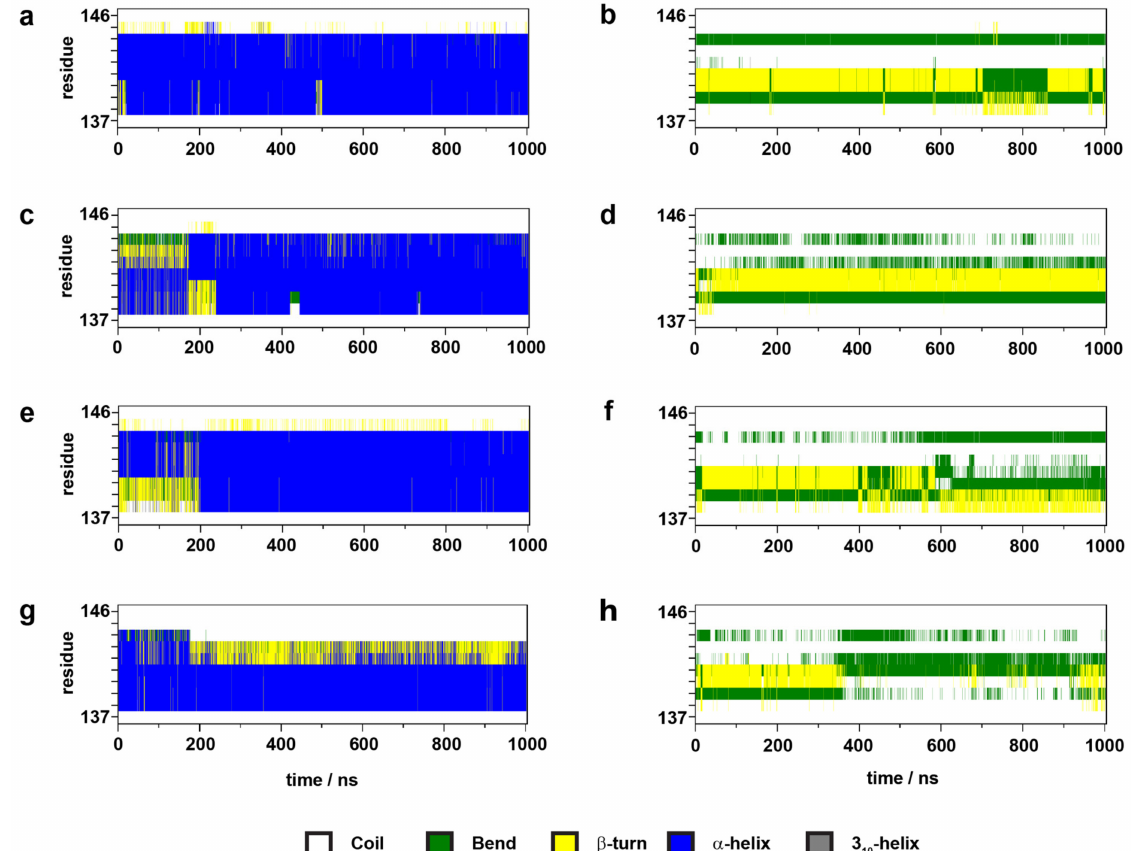
Figure 4. Evolution of the secondary structure of ICL2 during simulations. ( a ) active β 2 AR–G s protein–epinephrine complex, 1st replica; ( b ) inactive β 2 AR–G s protein – epinephrine complex; ( c ) active β 2 AR– β -arrestin-2–epinephrine complex; ( d ) inactive β 2 AR– β -arrestin-2–epinephrine complex. ( e ) active, ligand-free β 2 AR–G s protein complex; ( f ) inactive, ligand- free β 2 AR–G s protein complex; ( g ) active, ligand-free β 2 AR– β -arrestin-2 complex; ( h ) inactive, ligand-free β 2 AR– β -arrestin- 2